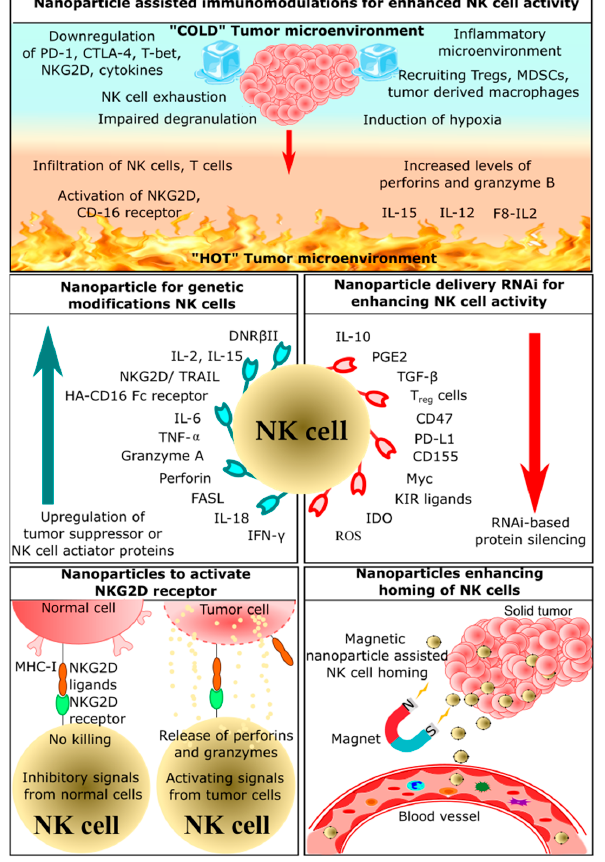
Figure 3. Schematic representation of various strategies for NK cell-based nano-immunotherapies. Adapted from [89–91].